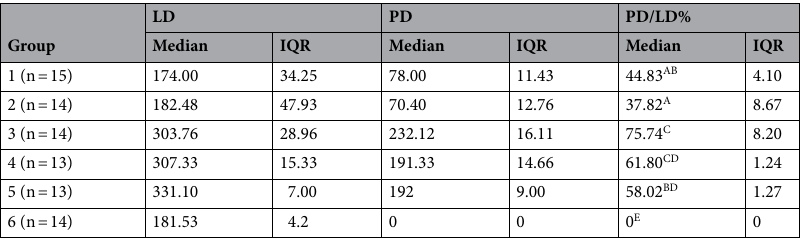
Table 1. Comparison of LD, PD, and %PD/LD in the study groups. LD Lesion depth, PD Sealant/infiltrant penetration depth, %PD/LD Percentage of PD to LD, IQR interquartile range. Values with the same